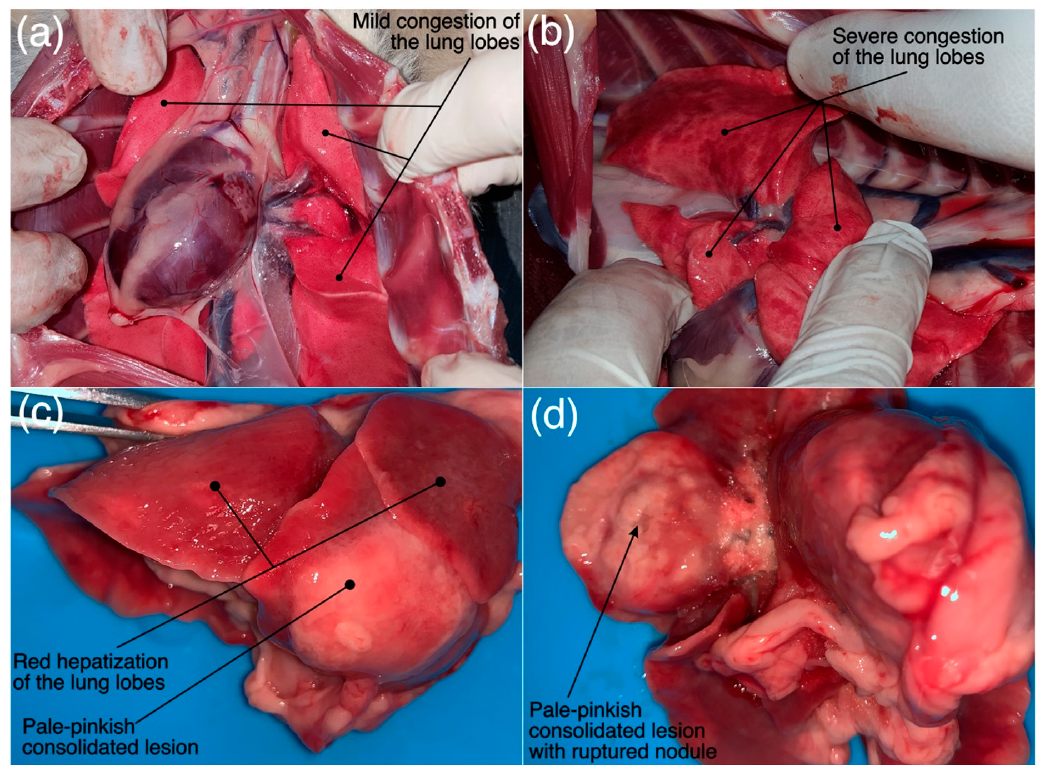
Figure 17. ( a – d ) Gross pathological findings (labeled) of ( a ) Cat 1 positive for FCoV and FCV antibodies and ( b ) Cat 2 positive for FIV, FCoV, FCV and FHV antibodies, presented with acute/chronic infectious respiratory disease signs and ( c,d ) Cat 25 diagnosed with pulmonary form of the feline rhodococcosis.